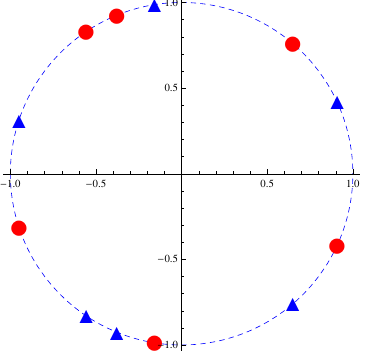
Figure 8 . The eigenvalue distribution of (cid:10) F for su (4) with one adjoint and one (020) fermions. The theory has four degenerate vacua labeled by di(cid:11)erent markers and distinct colors. The red (circle), blue (triangle), green (square), and yellow (club suit) vacua have tr F (cid:10) = 1 : 373(1 (cid:0) i ), (cid:0) 1 : 373(1 + i ), 1 : 373( (cid:0) 1 + i ), 1 : 373(1 + i ), respectively. All the four vacua break C , P , and T symmetries.